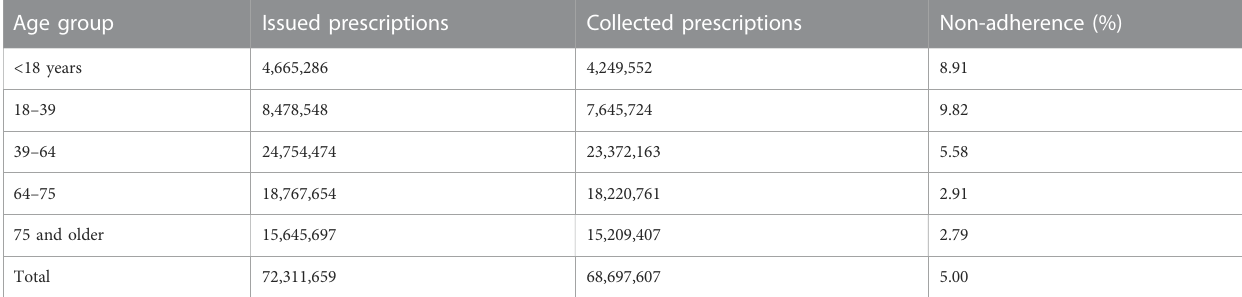
TABLE 2 Issued and collected electronic prescriptions in the Czech Republic in 2021. Age